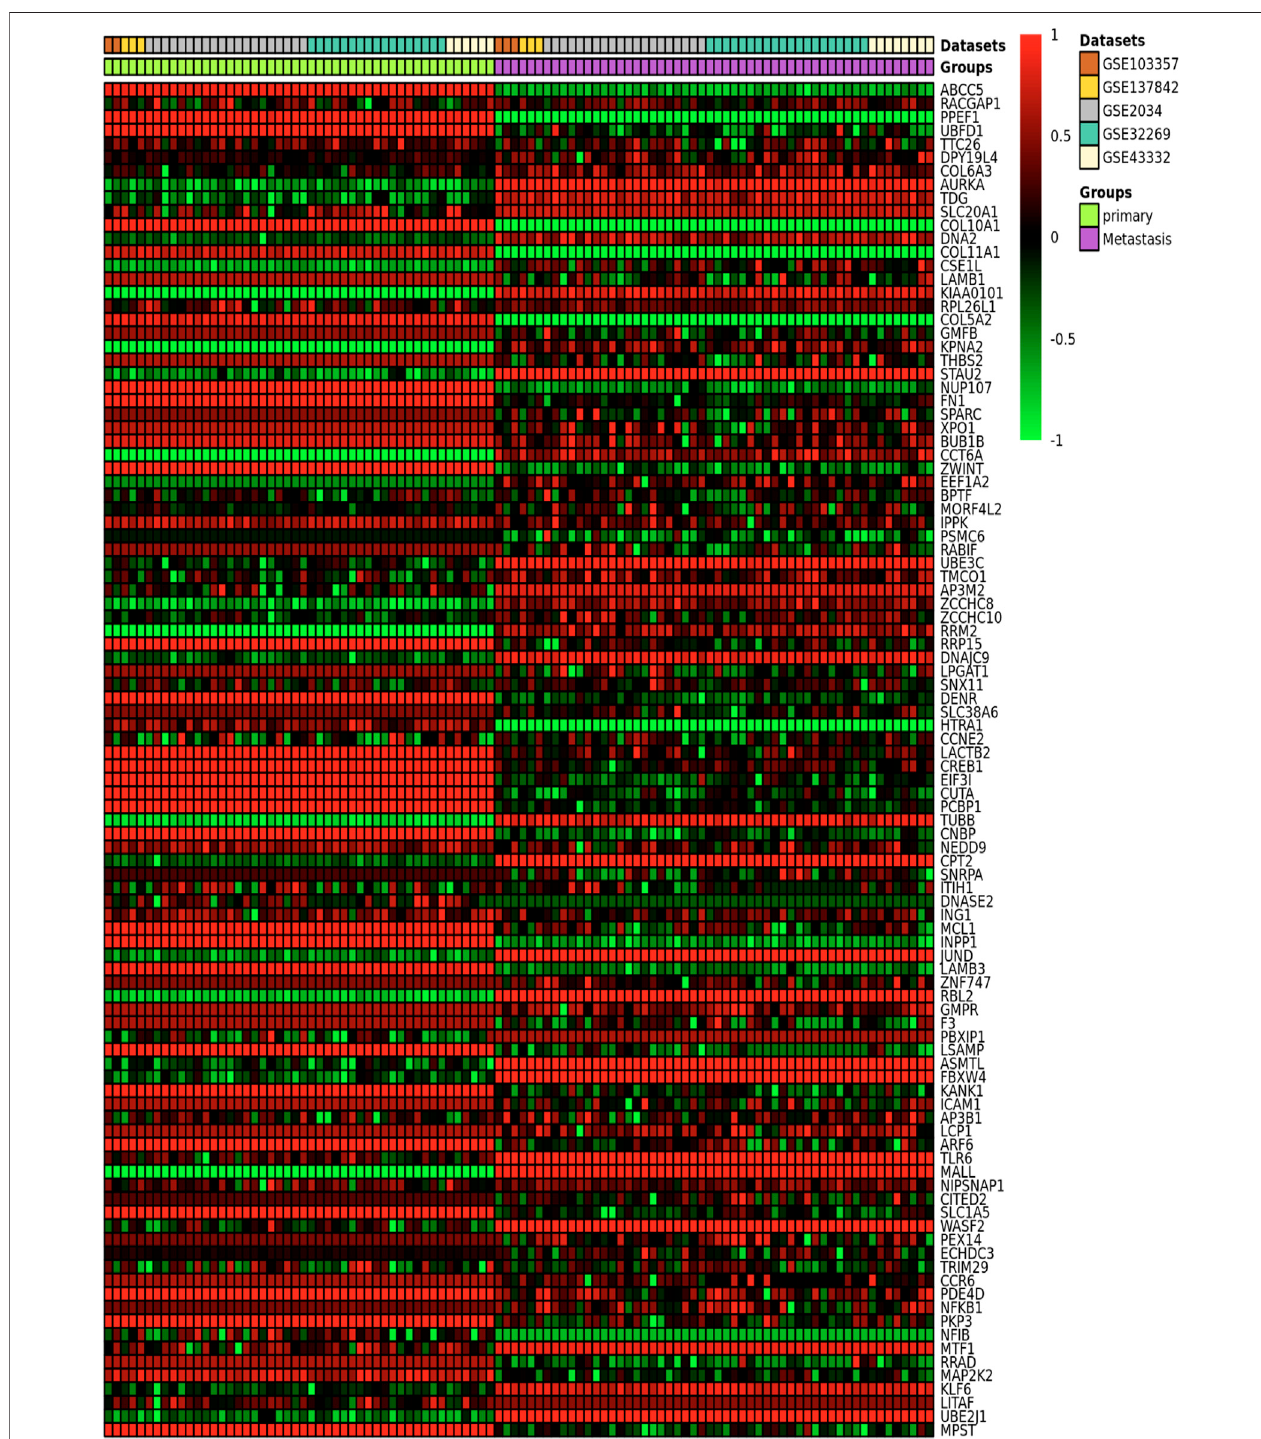
FIGURE 2 | An ImaGEO generated heatmap of the top 100 DEGs based on the fi ve microarray pro fi les.